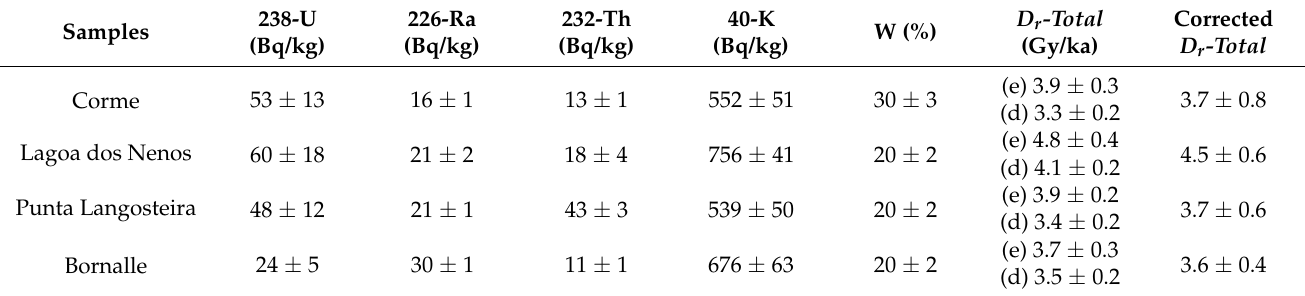
Table 1. Dose rate ( D r ). Radioisotopic activity from the 238-U, 232-Th and 40-K decay series. D r -Total assuming equilibrium (e) and disequilibrium (d) between 238-U and 226-Ra and the corrected D r -Total (Gy/ka). W, the percentage of estimated water saturation during the burial